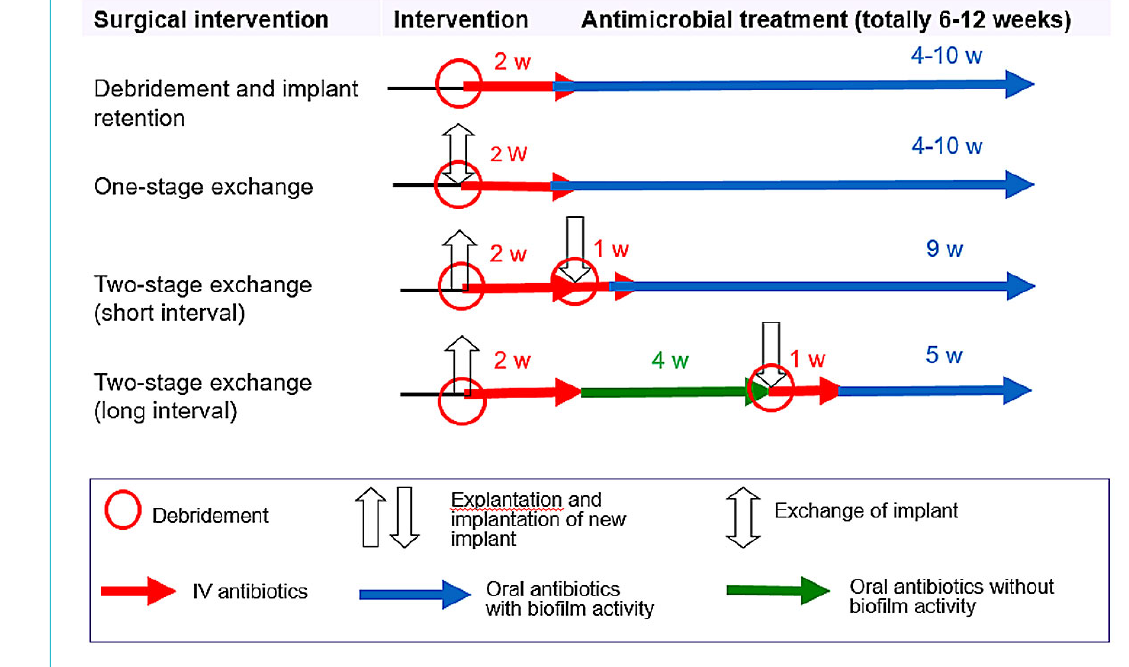
Figure 1: Treatment algorithm for implant-associated infections. Criteria for implant debridement and retention: acute infection (≤6 weeks postoperative), adequate soft tissue coverage, no implant dysfunction, availability of biofilm-active treatment, absence of life-threatening infec- tion (e.g., brain abscess or meningitis). Antibiotics with biofilm activity: rifampin for staphylococci and Cutibacterium spp.; fluoroquinolones for gram-negative bacilli.IV = intravenous; w =